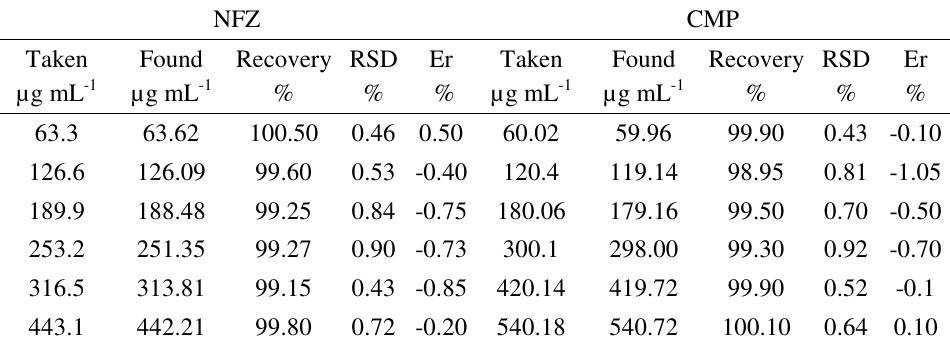
Table 4. The intra-day accuracy and precision data for the studied drugs obtained by conductometric method.